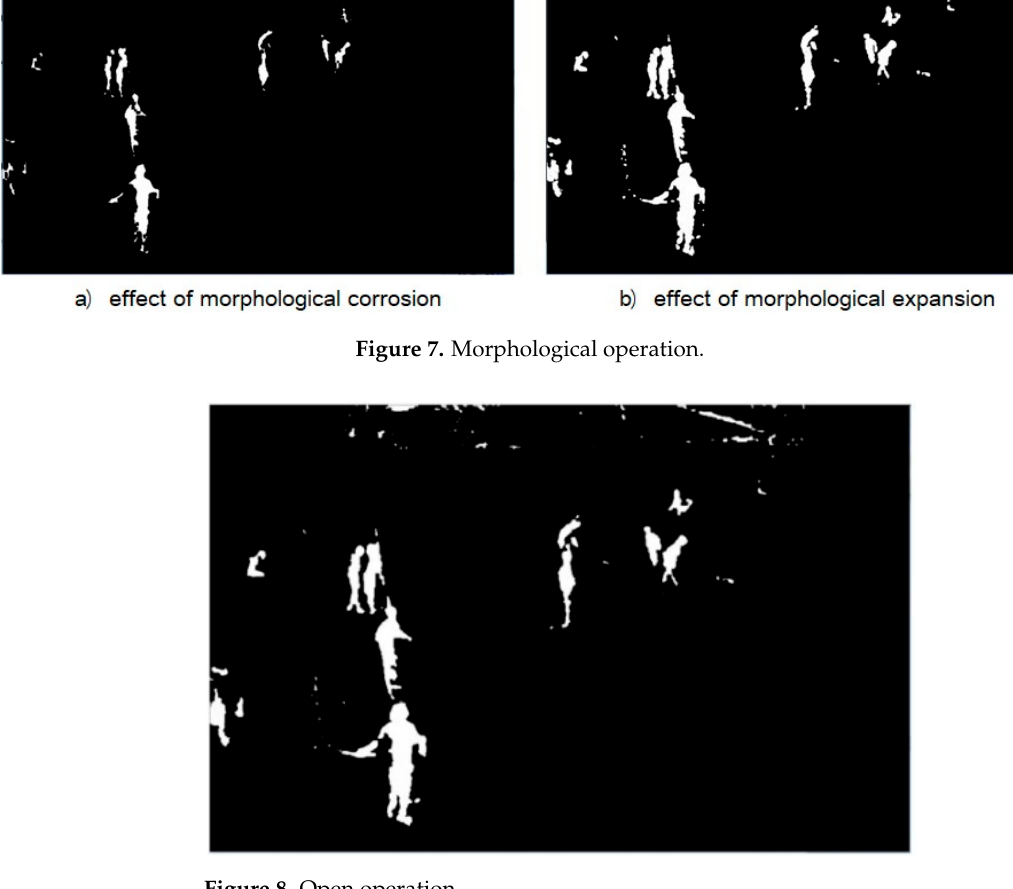
Figure 8. Open operation.